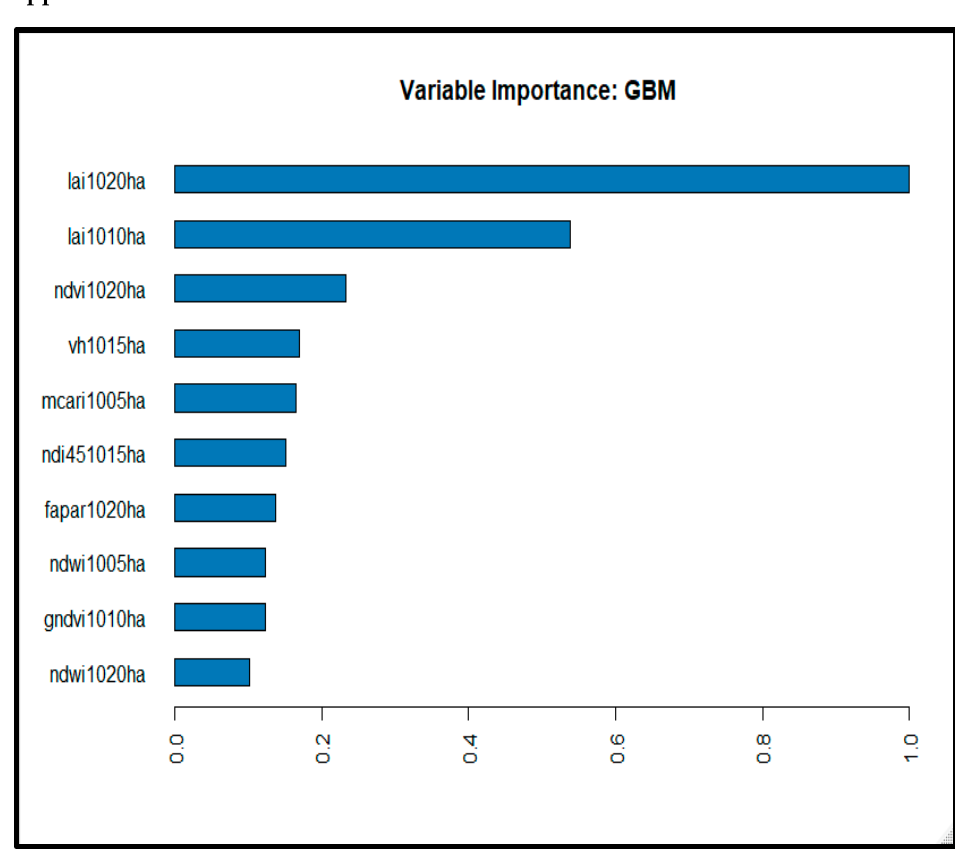
Figure A2. A plot showing the top ten most influential variables using the GBM model.